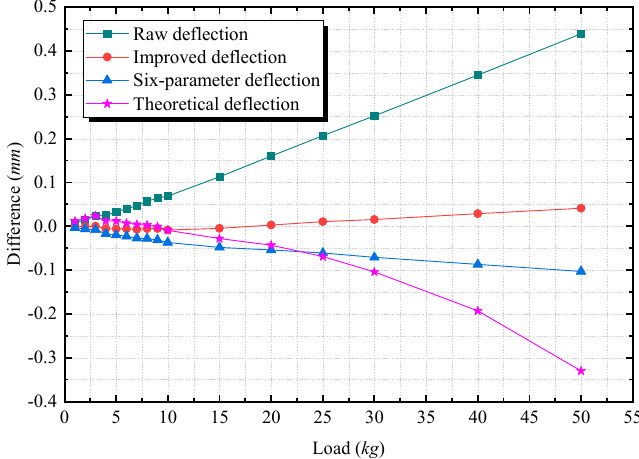
Figure 15. The di ff erences of the raw deflection, the improved deflection, the six-parameter deflection, and the theoretical deflection from the reference deflection. The di ff erence is equal to the value measured by di ff erent methods minus reference